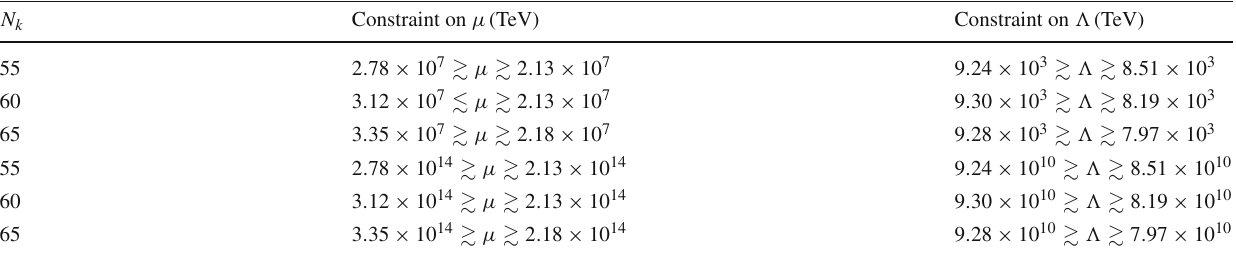
Table 6 Results for the constraints on the mass scales μ and (cid:5) for quadratic Hilltopinflationinthehigh-energy limitofRandall–Sundrum brane model using the last data of PLANCK. The top table shows the